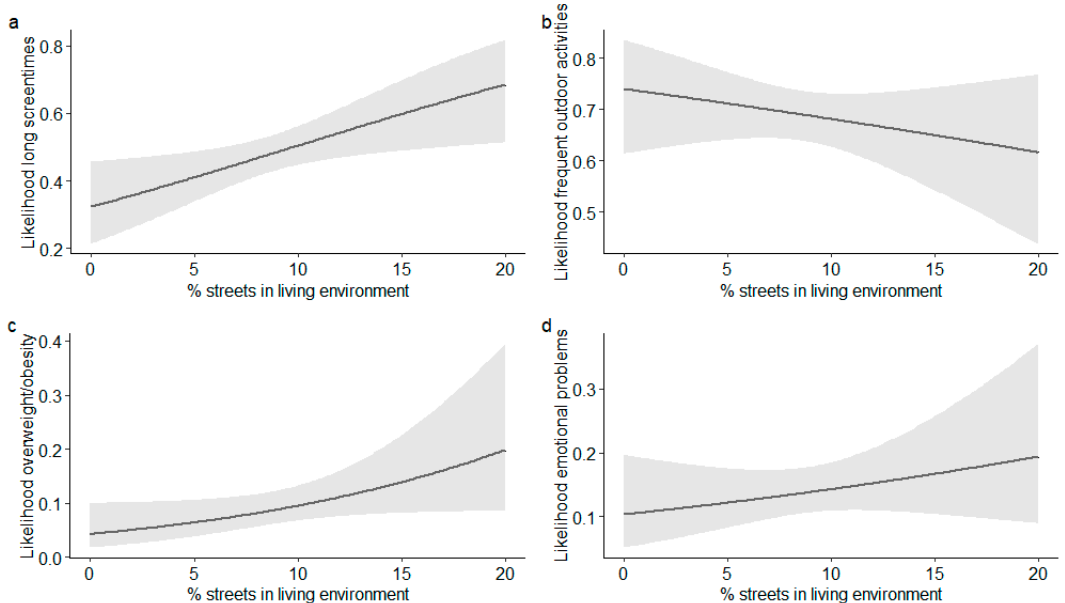
Figure 3. Effect plots illustrating the estimated effects (+95% CI) of the percentage of streets within 100 m of home on: ( a ) high screen times; ( b ) frequent outdoor activity in summer; ( c ) overweight/obesity; and ( d ) emotional problems in the sample of 3–10-year-old children.